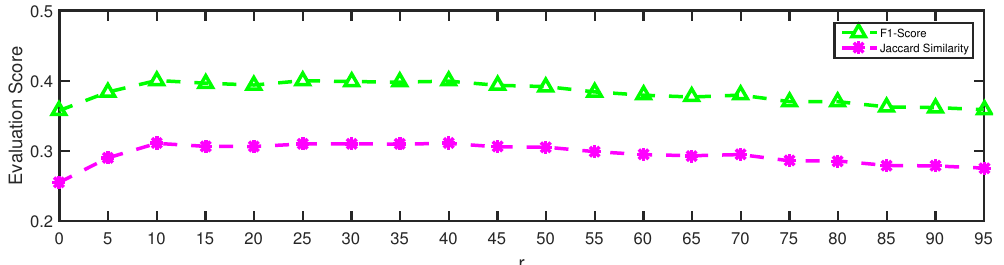
Figure 8. Varying the label weight threshold r from 0 to 95 with t = 10 on the Facebook